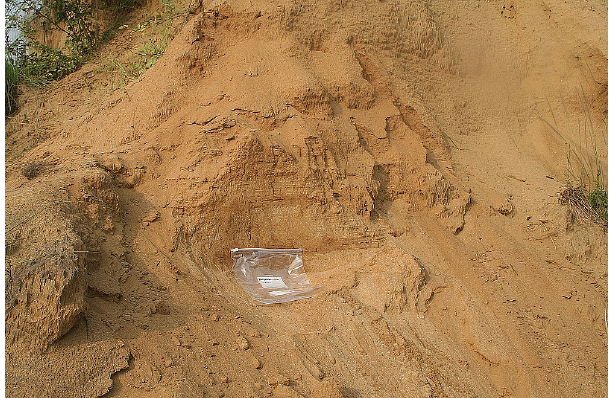
Figure A14. LH – cross-bedded sand exposure (4m high). Sam- ple was taken 2.2m from top of exposure, corresponding to OSL sample from unit dated at 23500 ± 1500 years by Verma (2016).